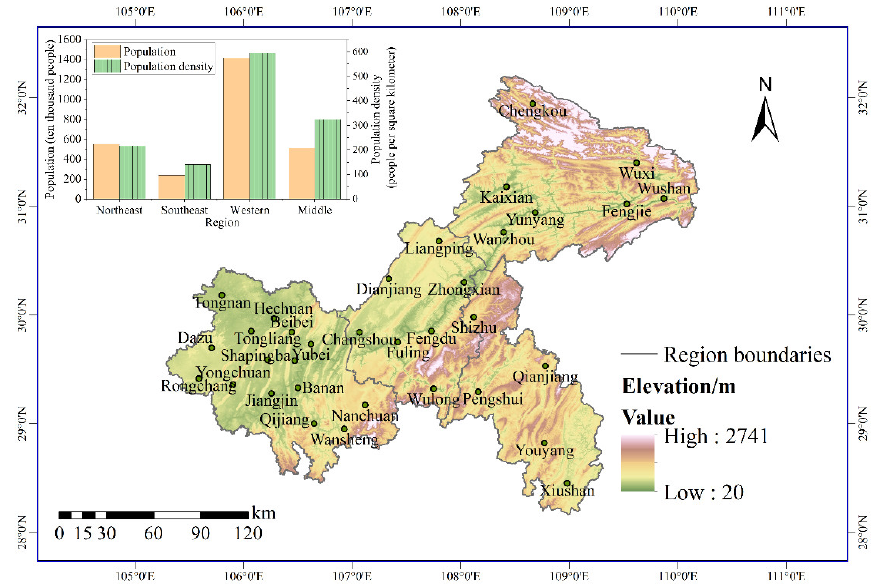
Figure 1. The Chongqing area and the distribution of meteorological stations.